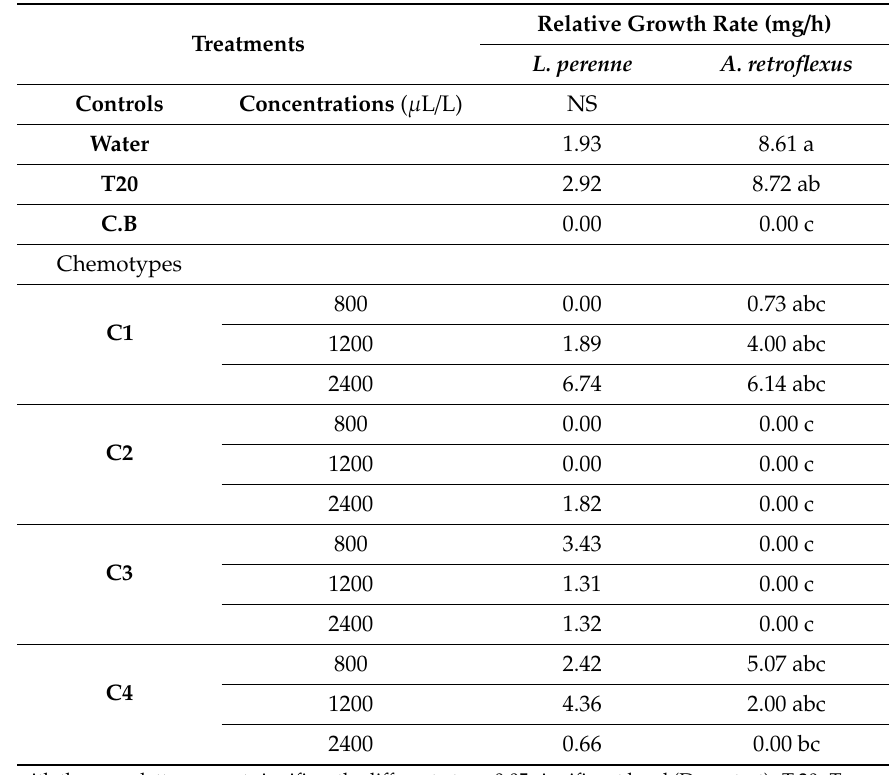
Table 5. E ff ect of the EOs on the relative growth rate of A. retroflexus and L. perenne seedlings 48 h after treatment. Relative Growth Rate (mg / Treatments